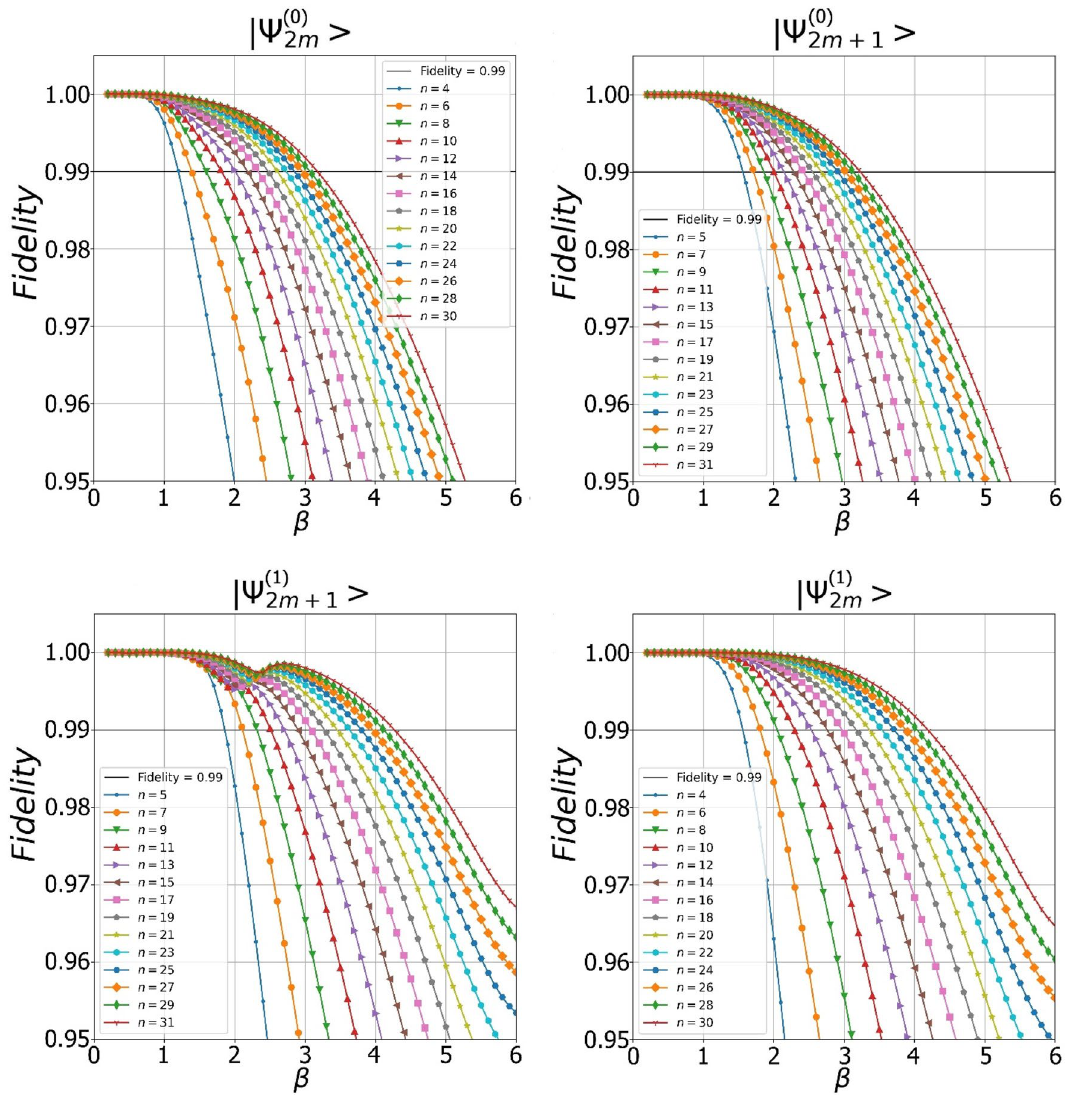
Figure 4. Dependencies of fidelities between the even/odd states from � ( 0 ) and � ( 1 ) families and real even/odd SCSs on its amplitude β . The more photons are extracted from the original SMSV state, the higher the fidelity of the output state is